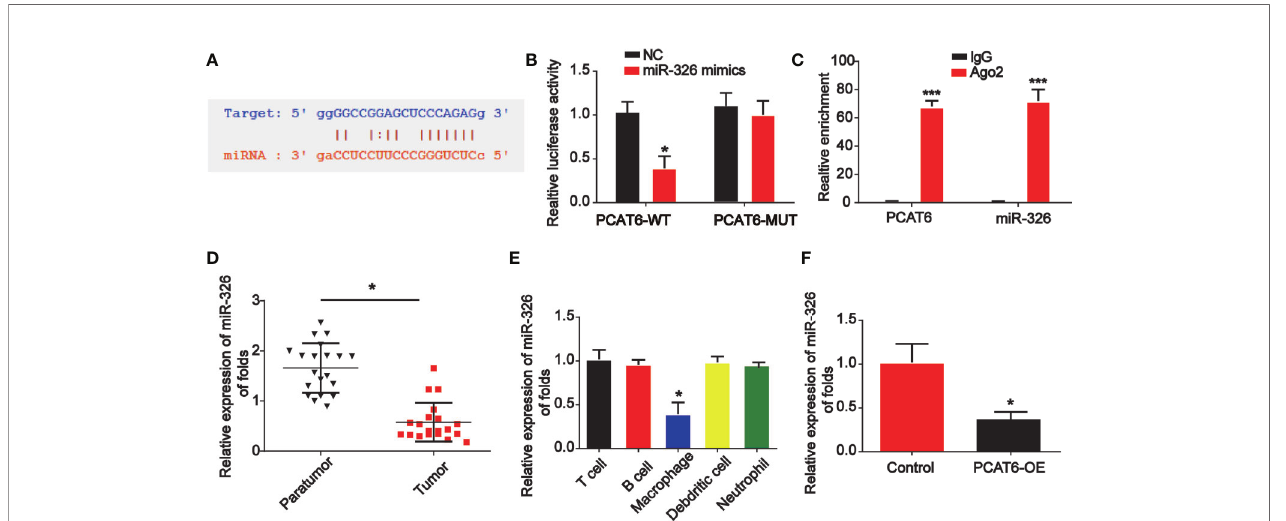
FIGURE 4 | PCAT6 sponged miR-326. (A) The putative binding sites between PCAT6 and miR-326. (B) Luciferase activity was evaluated in macrophages co- transfected with PCAT6-WT or PCAT6-MUT reporter and miR-326 mimics in THP-1-differentiated macrophages. (C) RIP assays were performed using anti-Ago2 and IgG antibodies with extractions from THP-1-differentiated macrophages. (D) The expression of miR-326 in the tumor tissues of cholangiocarcinoma (CCA) patients. (E) The expression of miR-326 in different types of patient-derived immune cells was assessed using qRT-PCR analysis. (F) The expression of miR-326 in